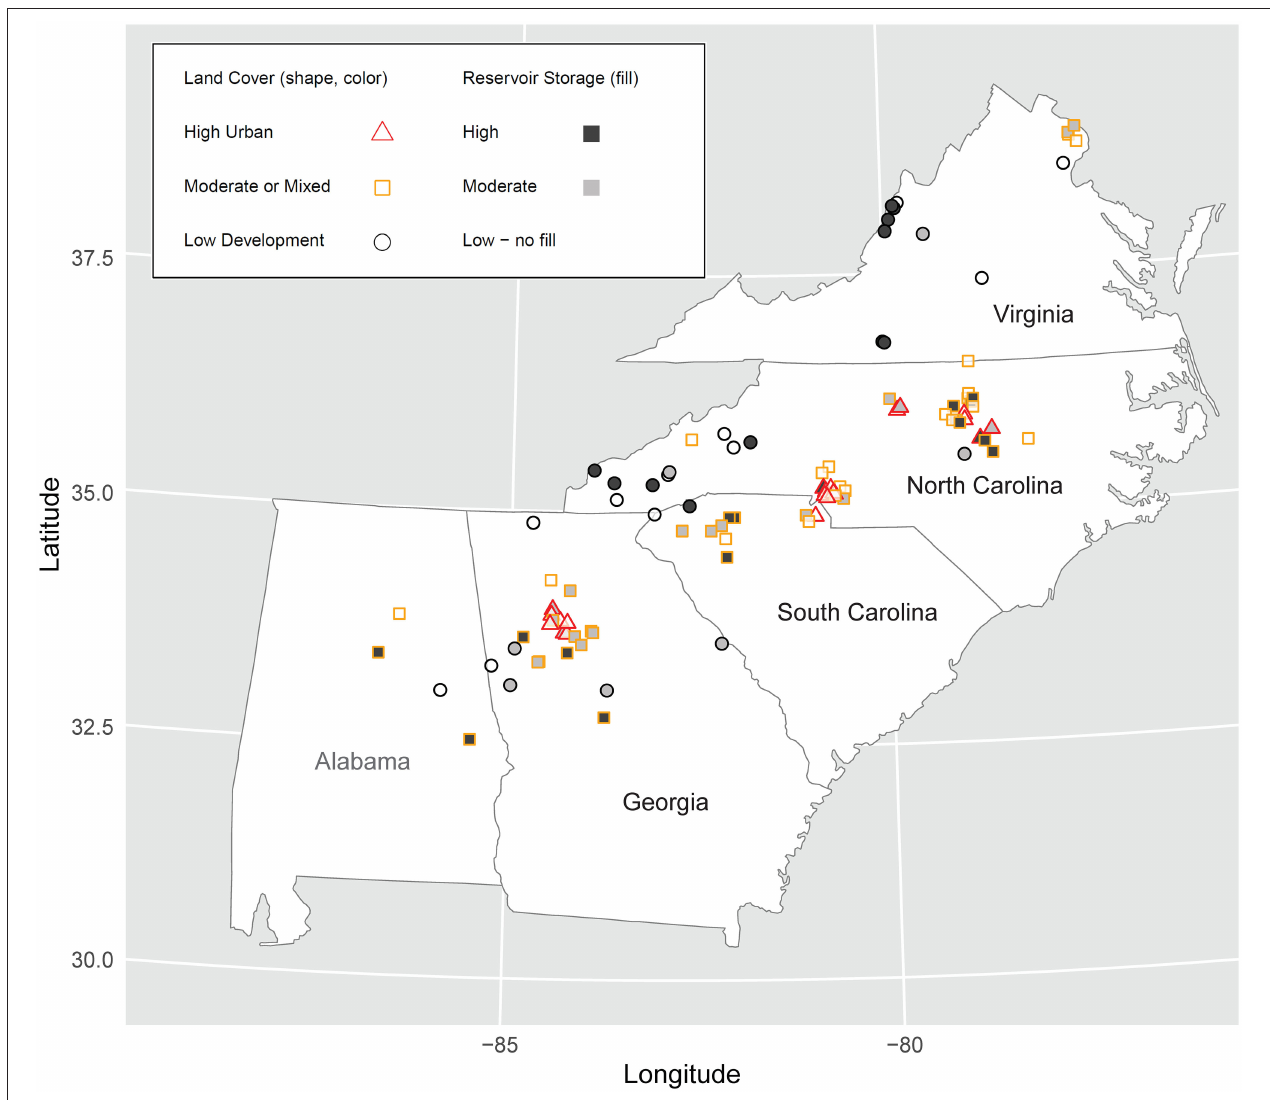
FIGURE 1 | Location of streams in the southeastern US categorized by land cover and reservoir